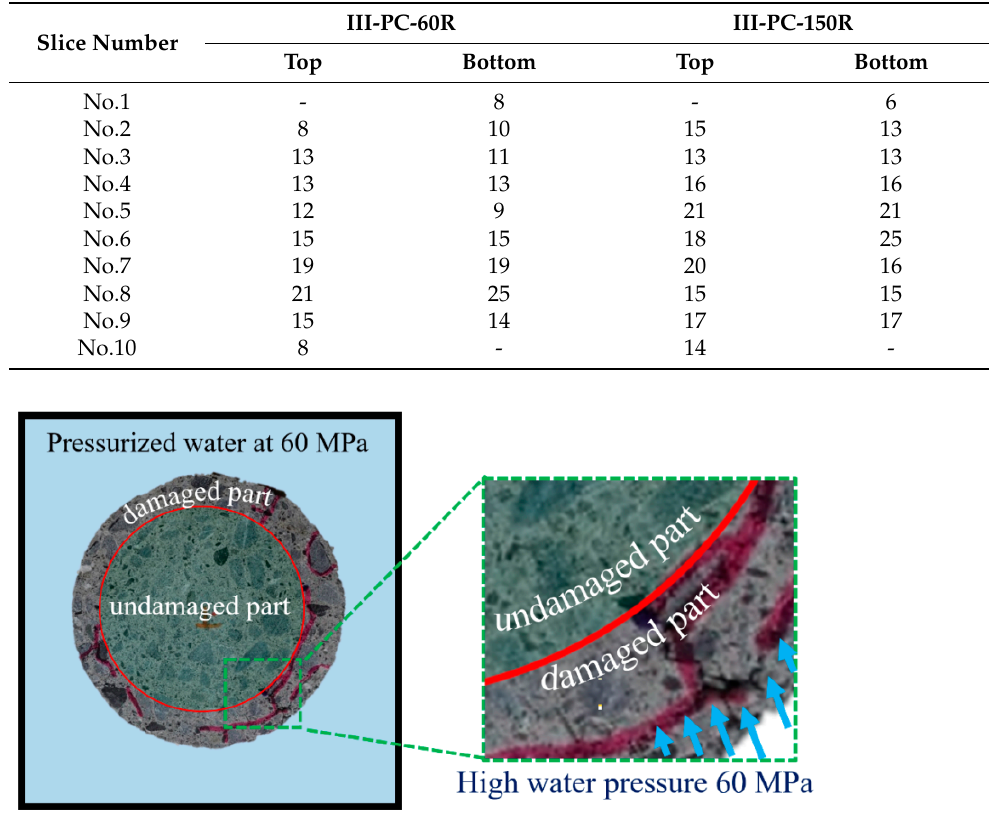
Figure 13. Penetration of the pressurized water inside the concrete specimen